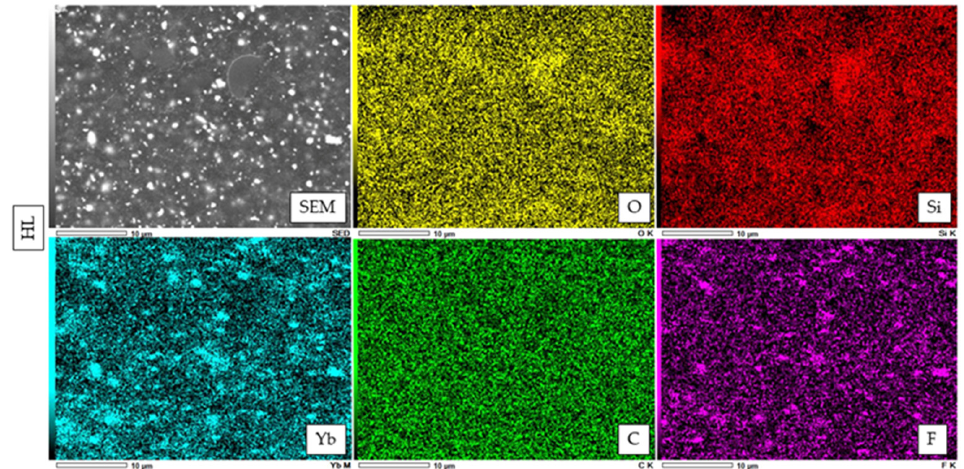
Figure 6. The representative EDX analysis picture of HL with a magnification of × 3000. The electron image obtained from the EDX analysis of HL reveals a widespread distribution of five significant elements. These elements are oxygen (O), silicon (Si), ytterbium (Yb), carbon (C), and fluorine (F).